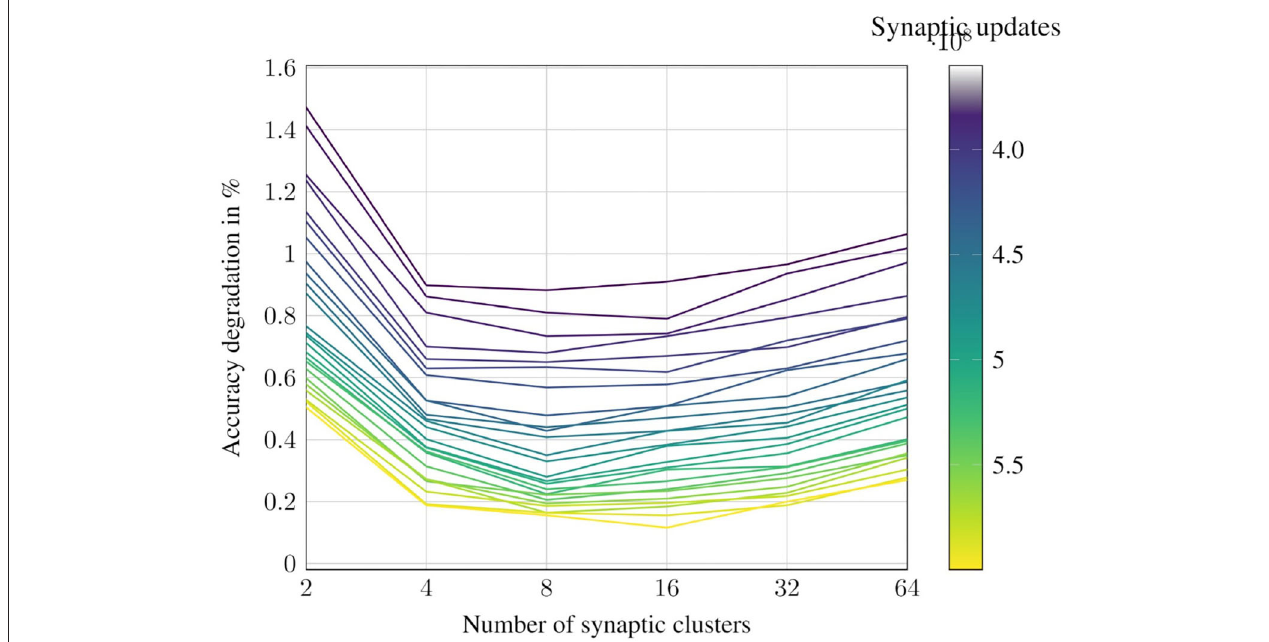
FIGURE 13 | Impact of varying the number of synaptic clusters for CIFAR10-AllConv.